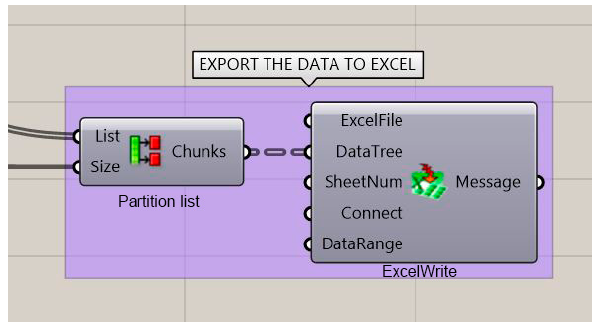
Figure 11. Algorithm to sort and export the data to Excel ® .